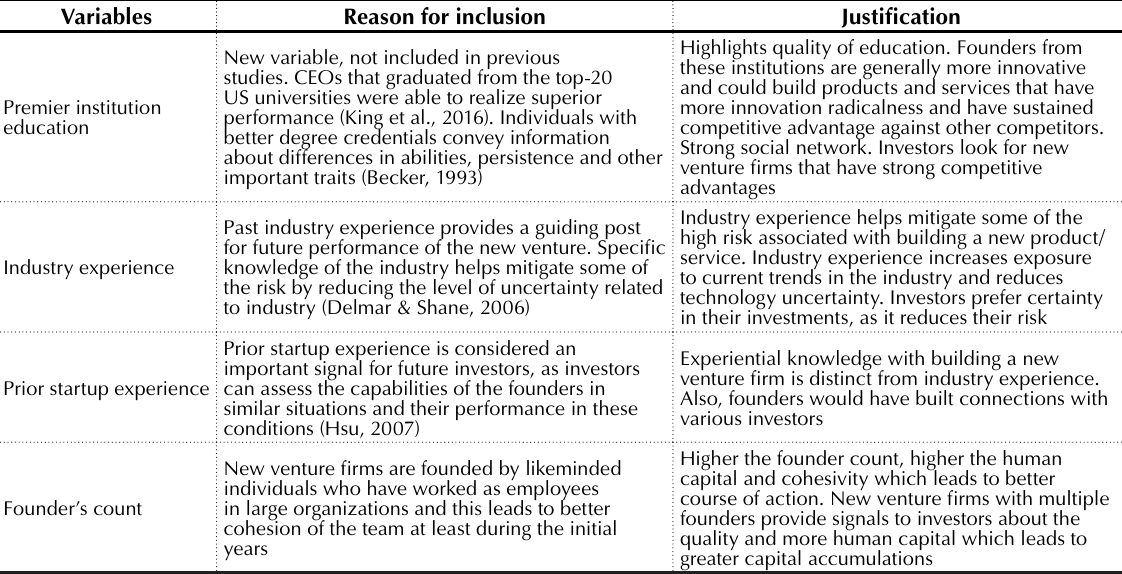
Table 1. Model development